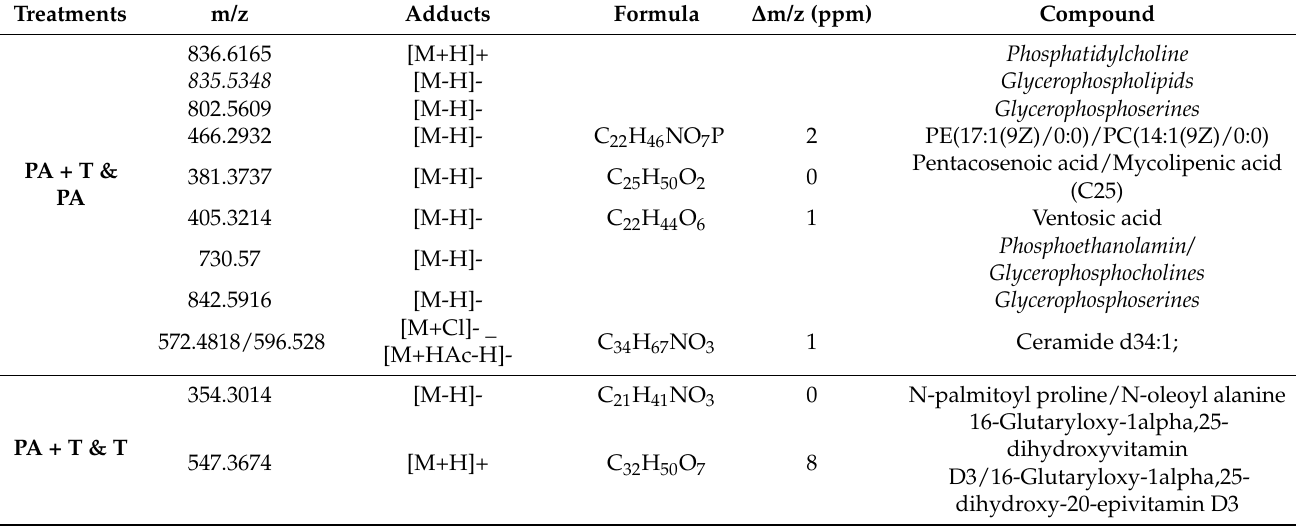
Table 2. List of annotated metabolites identified with CEU mass mediator for exometabolome. Metabolites written in italics were characterized by chemical family